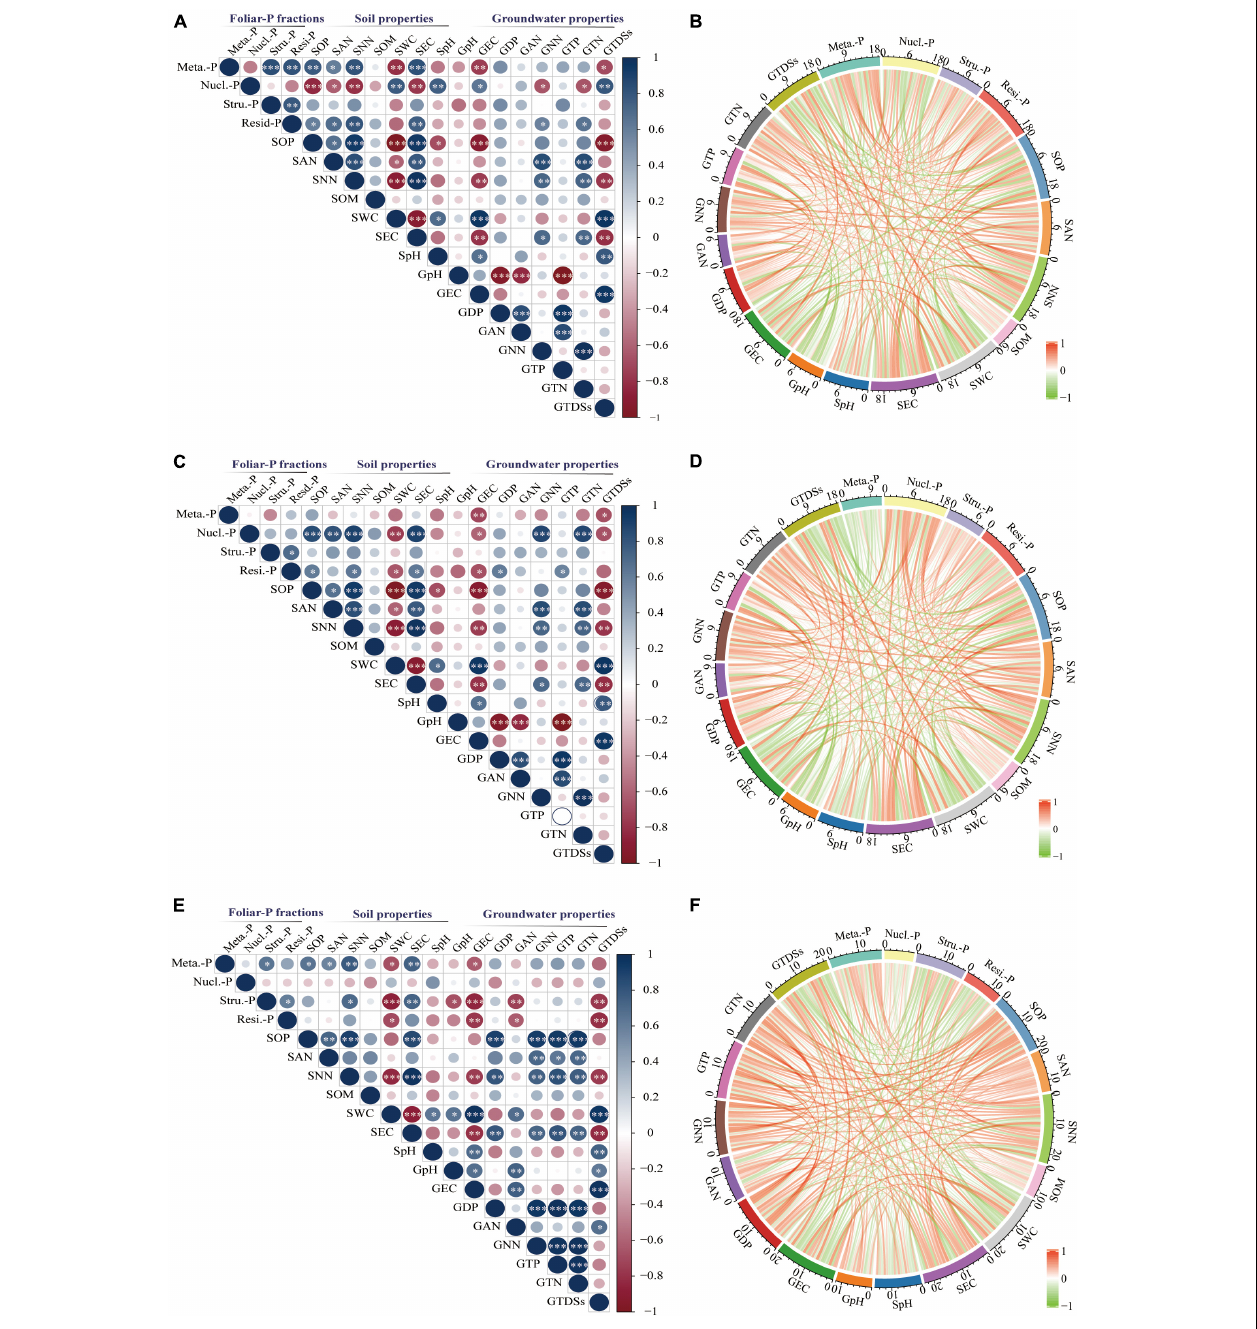
FIGURE 7 | Correlations between foliar-P fractions and soil and groundwater properties. Correlations between soil and groundwater properties and foliar-P fractions of K. caspia young leaves (A,B) , K. caspia mature leaves (C,D) , T. ramosissima mature leaves (E,F) , respectively. Stars represent the level of significance. No ∗ p > 0.05; ∗ p < 0.05, ∗∗ p < 0.01, ∗∗∗ p < 0.001. The sum correlations coefficient between foliar P-fractions and environment factors are expressed by the scale on each arc. Meta.-P: Metabolites-P; Nucl.-P: Nucleic acid-P; Stru.-P: Structural-P; Resi.-P: Residual-P; S: soil; G: groundwater; OP: Olsen-P; DP: dissolved P; AN: NH 4 + -N; NN: NO 3 - -N; TP: total-P; TN: total-N; SOM: soil organic matter; SWC: soil water content; TDSs: total dissolved